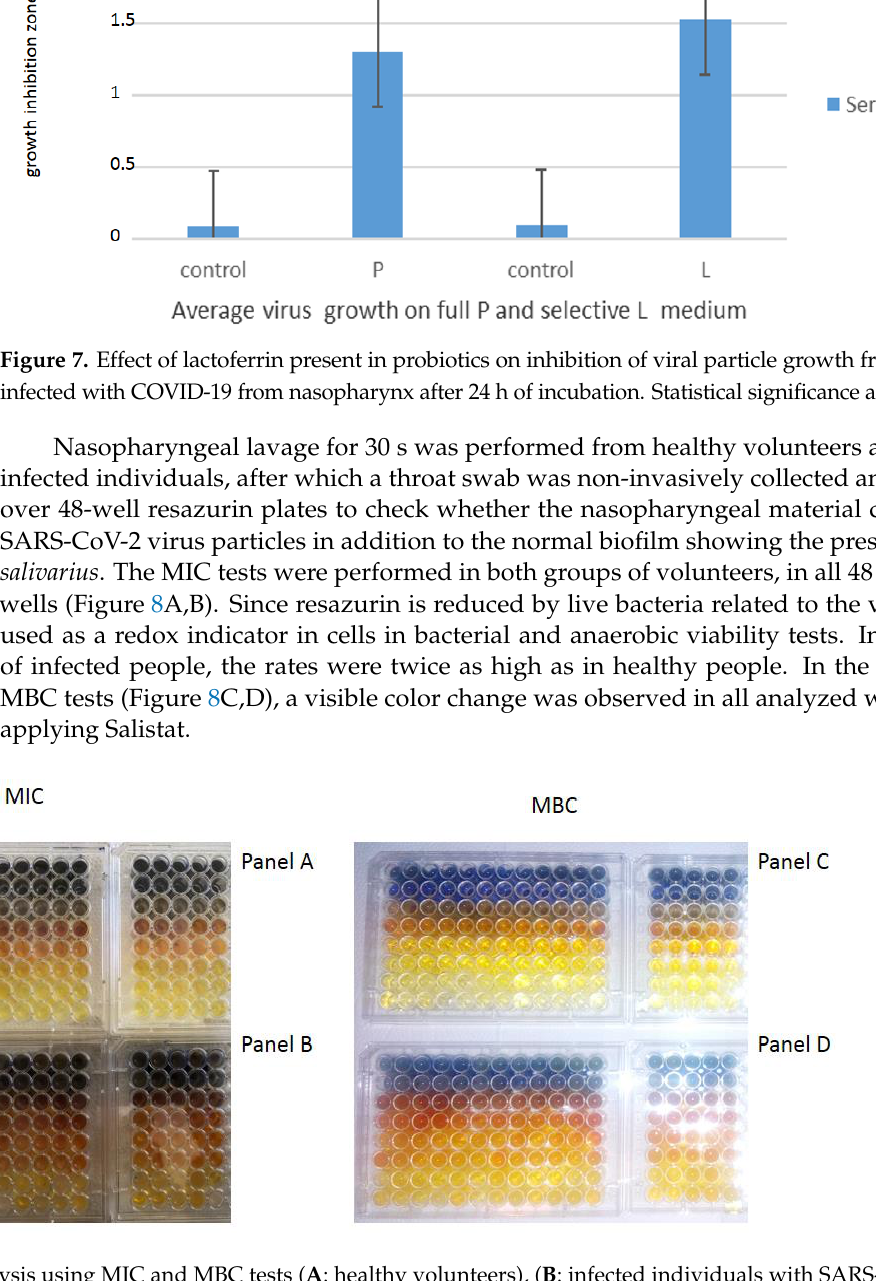
Figure 7. Effect of lactoferrin present in probiotics on inhibition of viral particle growth from peo- ple infected with COVID-19 from nasopharynx after 24 h of incubation. Statistical significance at p < 0.05 *.